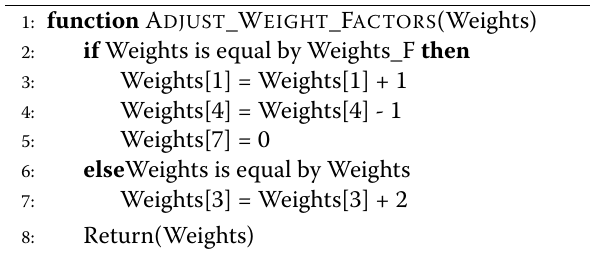
Algorithm 4 This is adjustment function. This function can affect up to %10 in the major revision needed. There- fore, it can be an optional